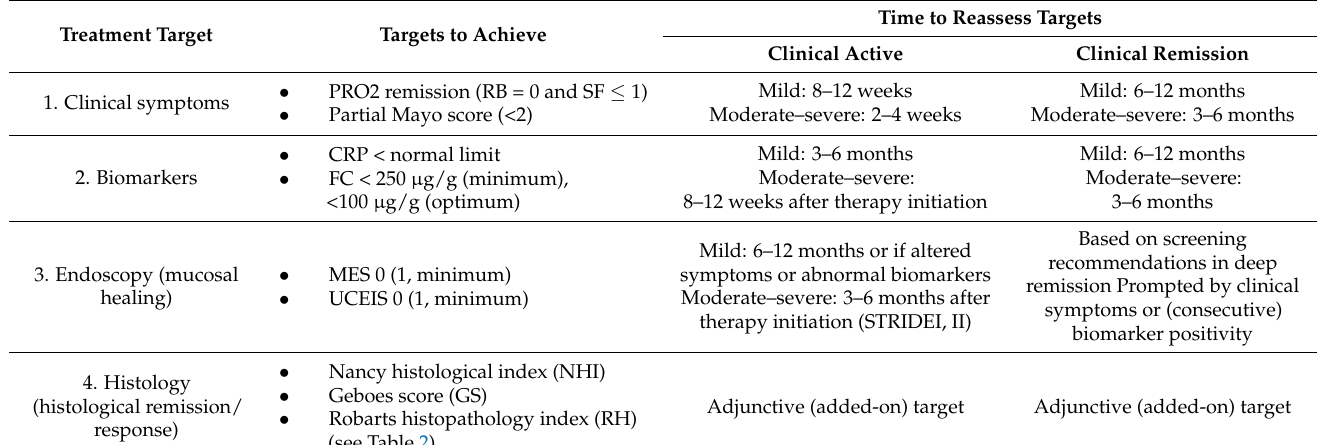
Table 1. Summary of proposed recommended targets of “treat-to-target” approach in UC management. Treatment Target